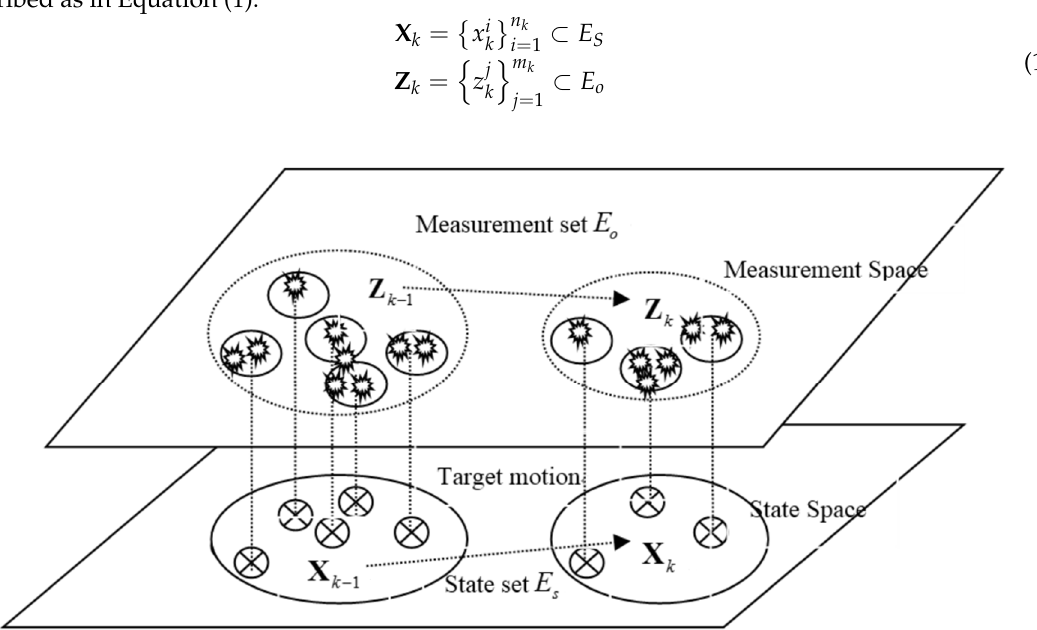
Figure 1. The space model of multi-targets tracking.